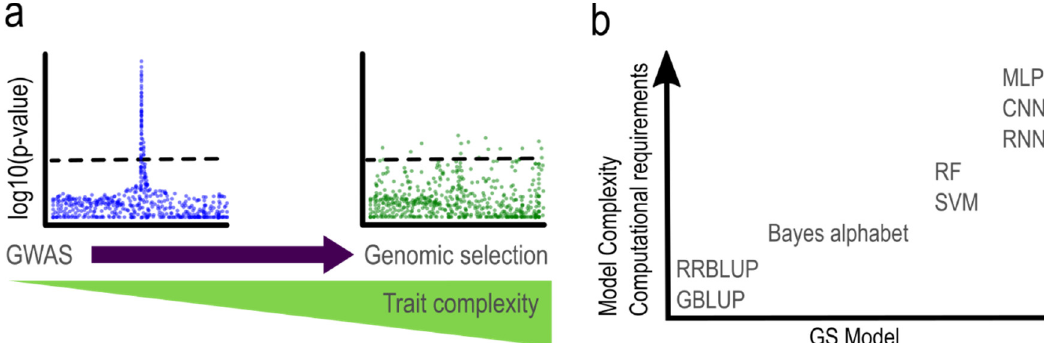
Figure 1. Indirect selection based on molecular markers. ( a ) Generalized Manhattan plots illustrating a comparison of GWAS effectiveness in simple (left) vs. complex traits (right). Note: Bold dashed line indicates minimum threshold to select significant markers. A significant signal (i.e., QTL) was identified in the simple trait (left panel), while no defined QTL was identified for the complex trait. Therefore, genomic selection (GS) is more appropriate and practical for complex traits. ( b ) Common parametric and non-parametric models used in GS and their computational requirements. GBLUP, genomic best linear unbiased prediction; RRBLUP, ridge-regression BLUP; RF, random forest; SVM, support vector machine; MLP, multilayer perceptron; CNN, convolutional neural network; RNN, recurrent neural network.